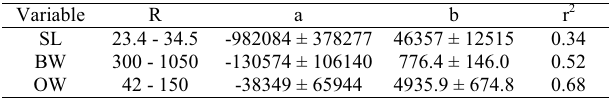
Table 2 . Linear regression (Y = a + bX) of absolute fecundity (n = 26) versus standard length (SL, cm), body weight (BW, g) and ovarian weight (OW, g) of yellow-mandis from Igara- pava Reservoir; R = range of variable; a = regression con- stant ± standard deviation; b= regression coefficient ± stan- dard deviation; r 2 =